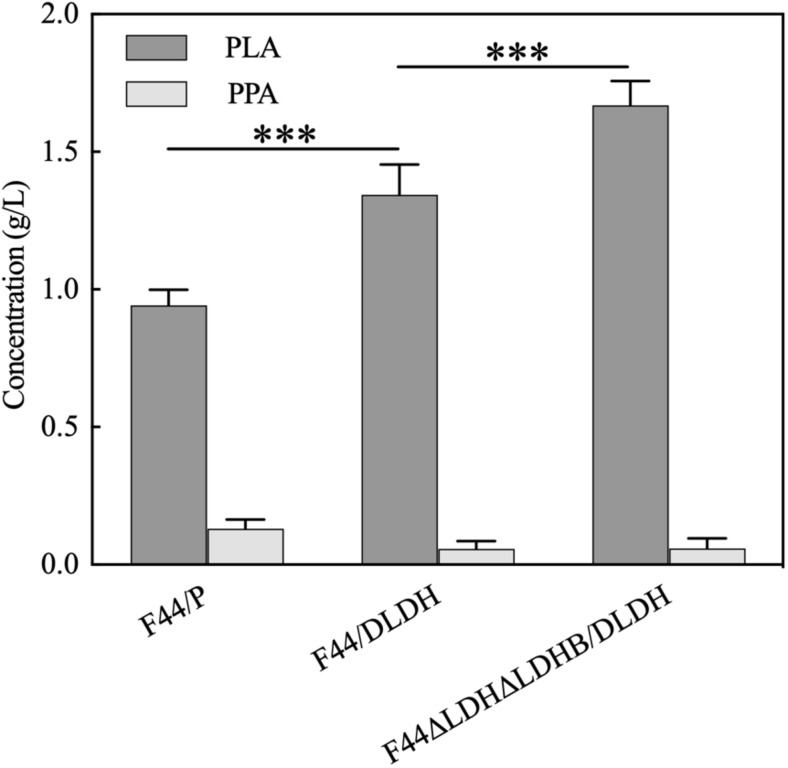
PLA and PPA concentrations of 12 h-culture supernatants of L. lactis F44/P and PLA-producing strain F44/DLDH, F44ΔLDHΔLDHB/DLDH. The error bar presented SD indicating the repeatability of the data in three-testing. The data were analyzed by One-way ANOVA. The yield of PLA in strain F44ΔLDHΔLDHB/DLDH was significantly different (***P < 0.01) from that in F44/P and F44/DLDH, respectively.